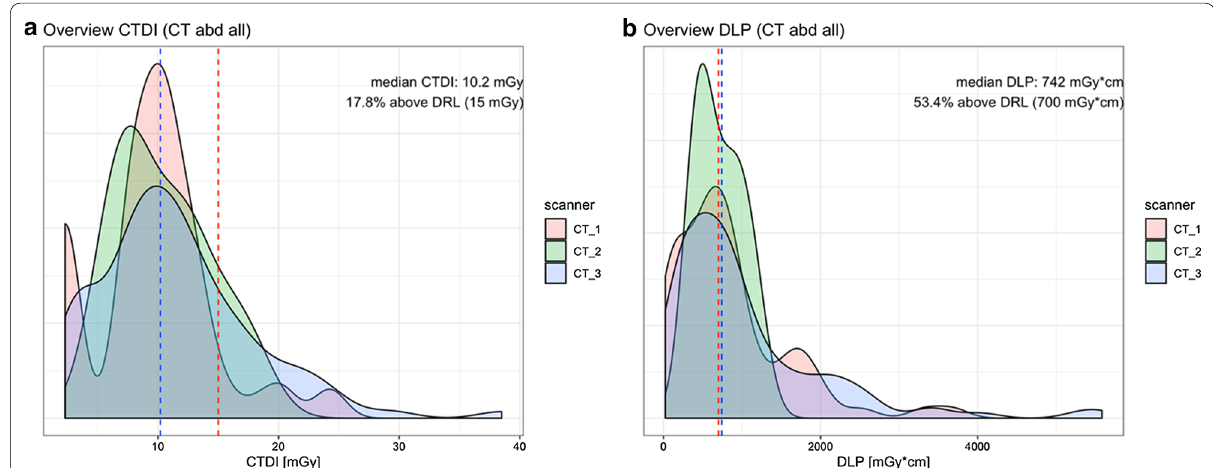
Fig. 2 Dose monitoring for a dedicated CT protocol (CT abdomen) with comparison of three different scanners. The red line demonstrates the DRL for regular patients (70 kg). The graph shows that some studies (17,8%) have CTDIs higher than expected, and DLP is often above limits